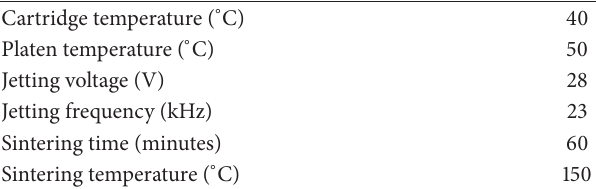
Table 4: Printing